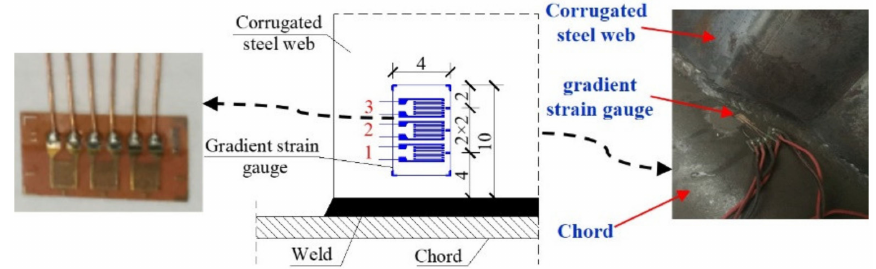
Figure 7. Gradient strain gauge (unit: